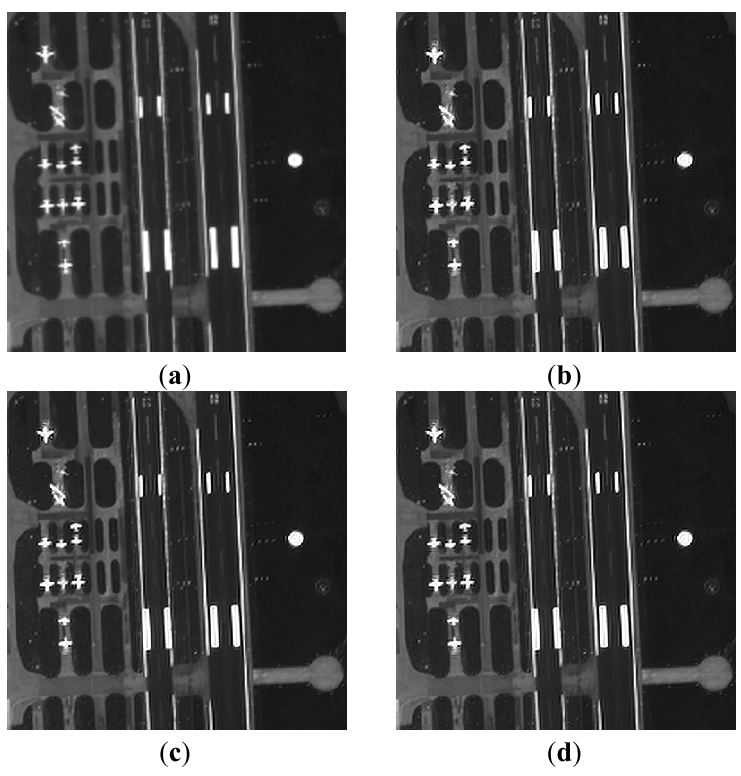
Figure 9. SRR results of the real multi-angle remote sensing images. ( a ) bilinear